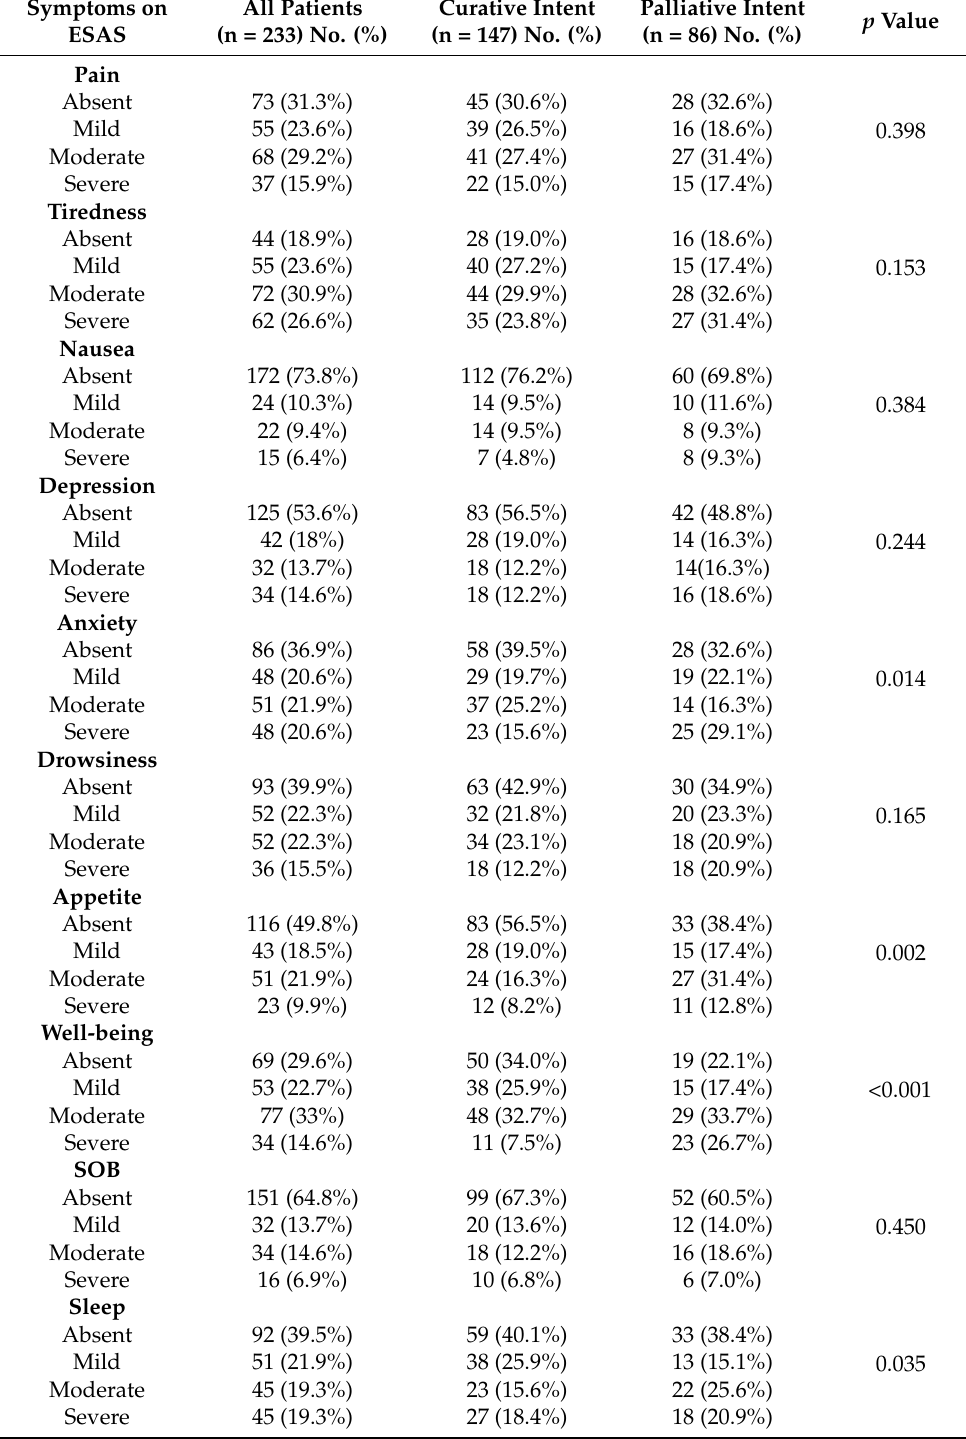
Table 2. Reported symptoms on the